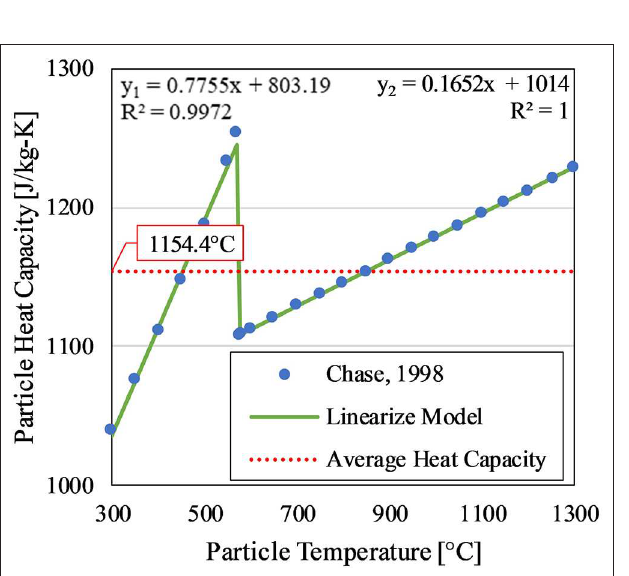
FIGURE 5 | Temperature-dependence of the particle’s heat capacity. The linear equations y1 and y2 correspond to the linear regression lines for the lower ( < 573 ◦ C) and higher ( > 573 ◦ C) temperature ranges, respectively. The linearized model was based off silica heat capacity profiles from Chase (1998). The average heat capacity was the average over the operating range of 300–1,200 ◦ C.